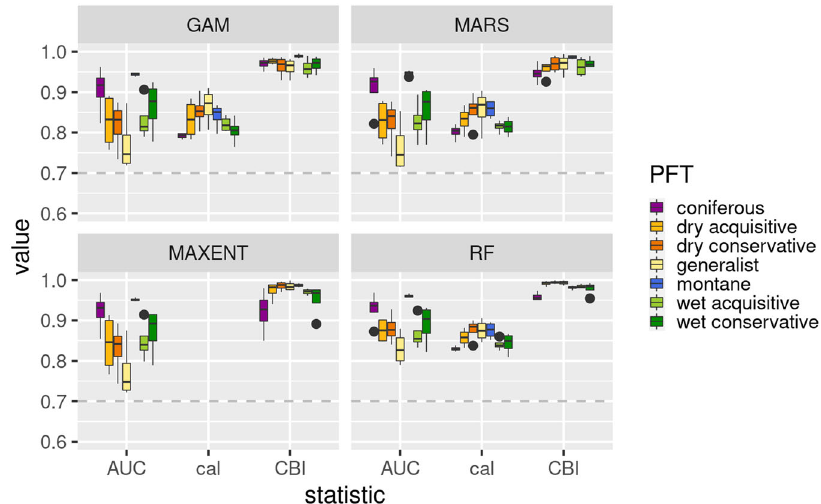
Fig. 5 Model evaluation. Summary of the evaluation metrics Area under the curve (AUC), calibration statistic (cal) and Continuous Boyce Index (CBI) for each algorithm (GAM = Generalized Additive Model, MARS = Multivariate Adaptive Regression Splines, MAXENT = Maximum Entropy, RF = Random Forest) and by species group. The dashed line represents the applied model selection threshold